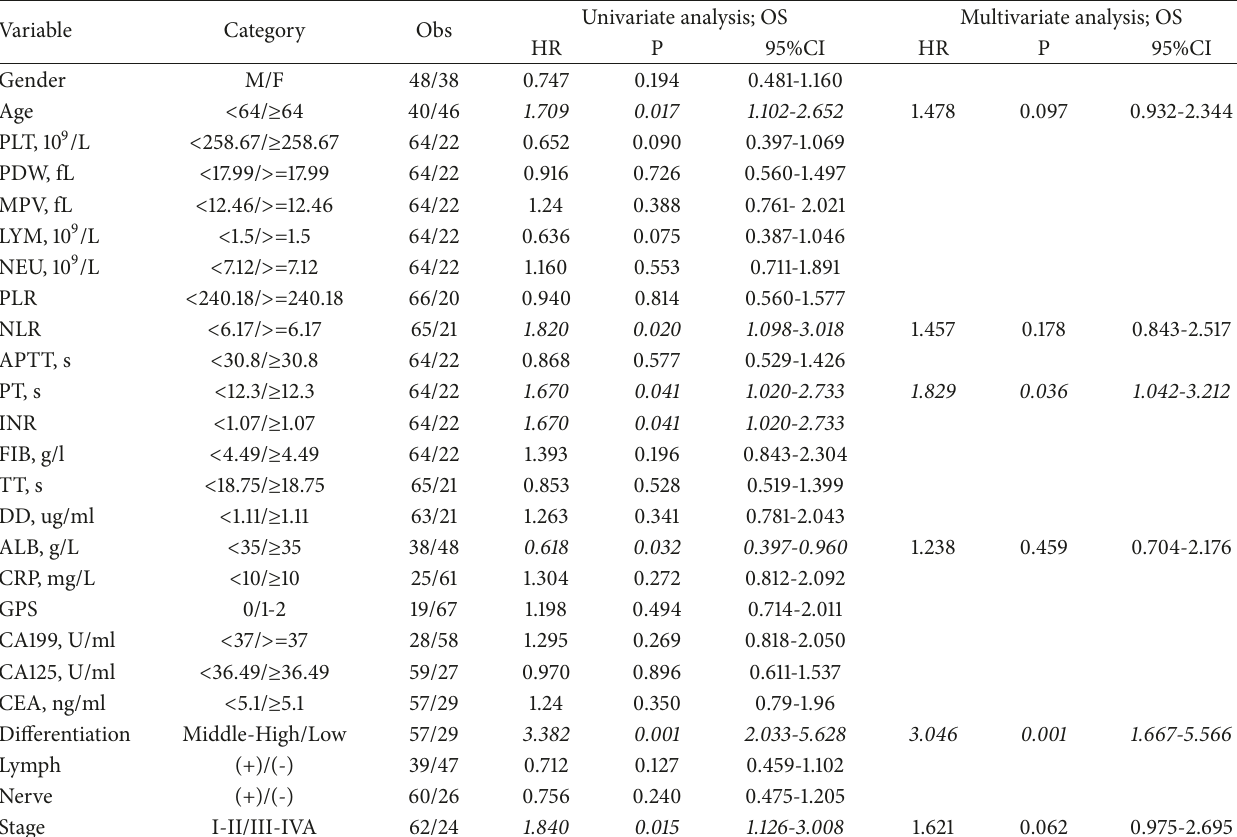
Table 2: Univariate and multivariate analyses of relationship between various clinical factors and overall survival (OS). Variable